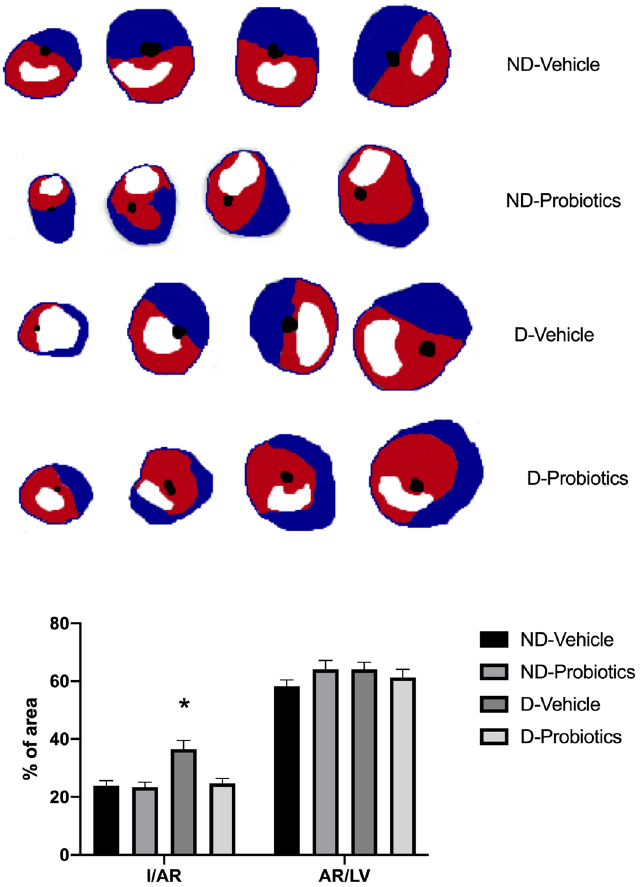
Figure 1. Upper panel: Representative images of myocardial infarction observed in the different groups (Blue: Evans Blue positive, normal region, White: TTC positive infarction, Red: TTC negative, Red and White represent AR). Lower panel: Infarct size (I) expressed as a percentage of the area at risk (AR), and AR as a percentage of the left ventricle (LV) after 24 h reperfusion. *p < 0.05 versus ND-vehicle and D-probiotics. ND none-dysbiotic, D